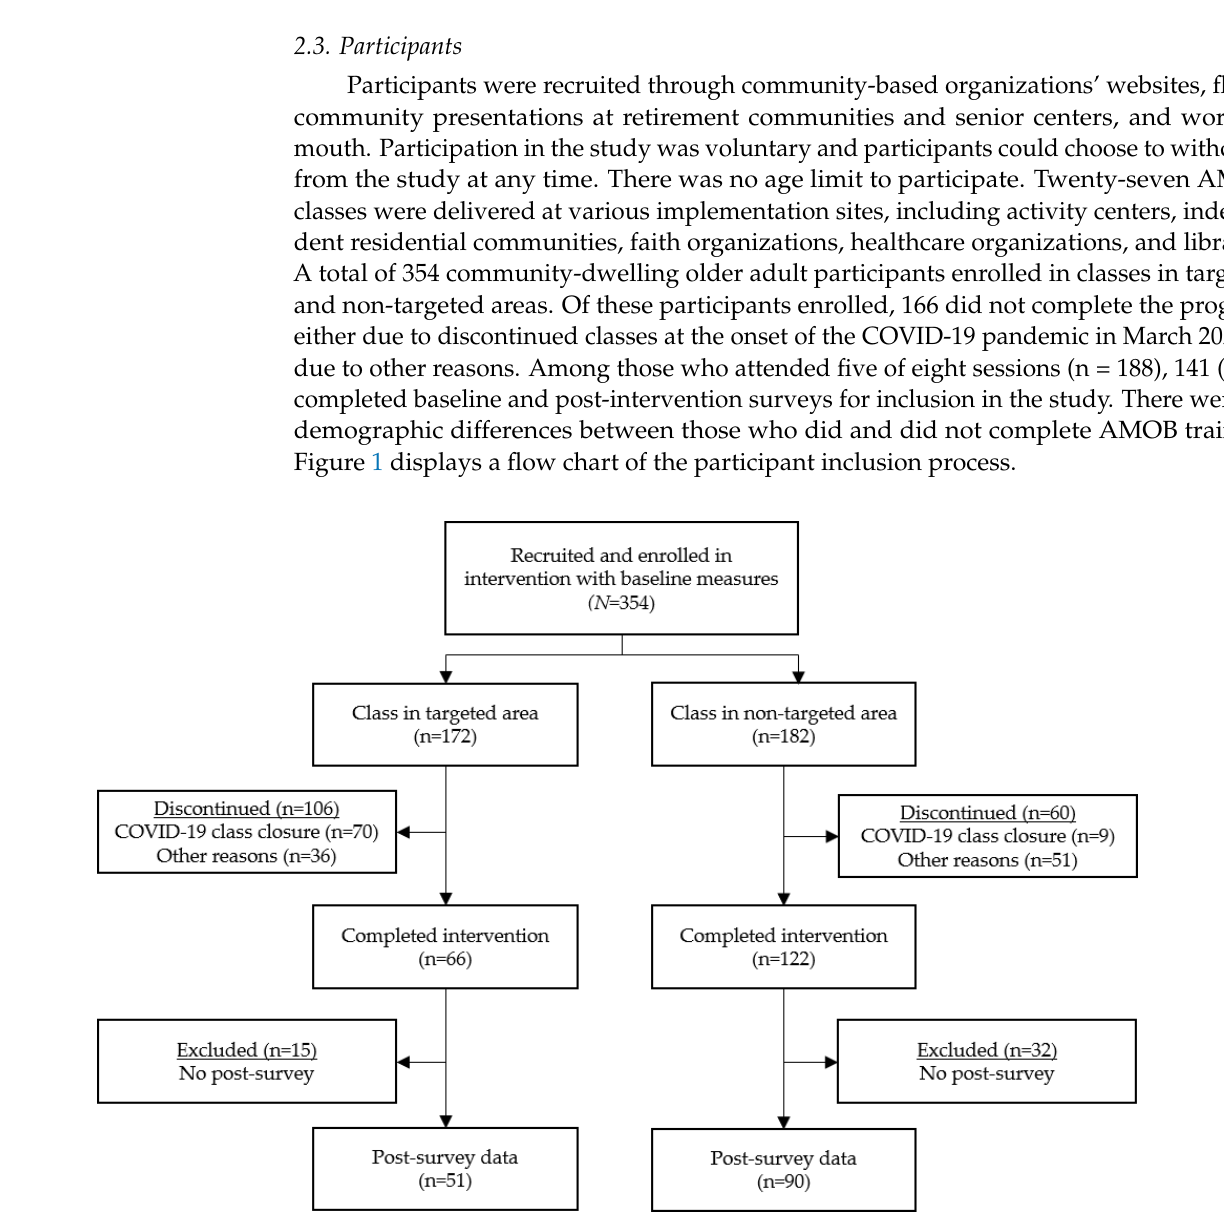
Figure 1. Participant inclusion flow chart.